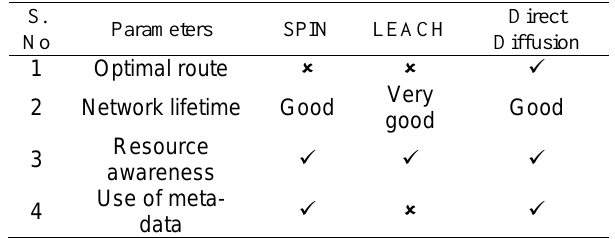
Table 1. Comparison between SPIN, LEACH and Direct